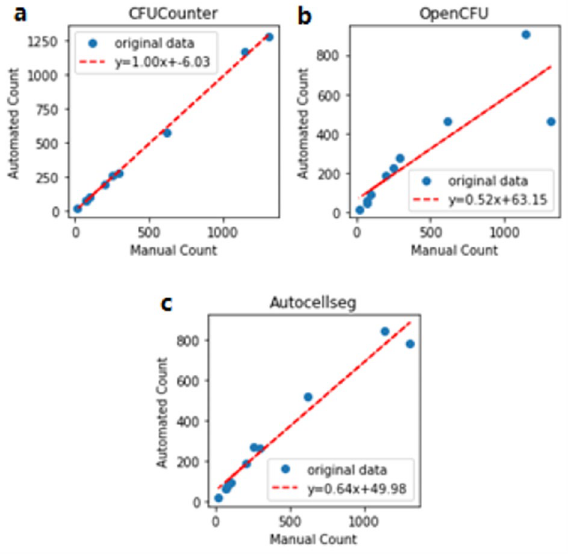
Fig. 3 Linear regression of CFU counts using each method compared to the true number of CFU. a Accuracy of cell counter compared to the ground truth (slope 0.996; SD 0.013; 95%CI: 0.97–1.02; p value < 1e-11); b Accuracy of OpenCFU compared to the ground truth (slope 0.515; SD 0.101; 95%CI: 0.316–0.713; p value < 0.001) c Accuracy of AutoCellSeg compared to the ground truth (slope 0.638; SD 0.042; 95%CI: 0.555–0.721;